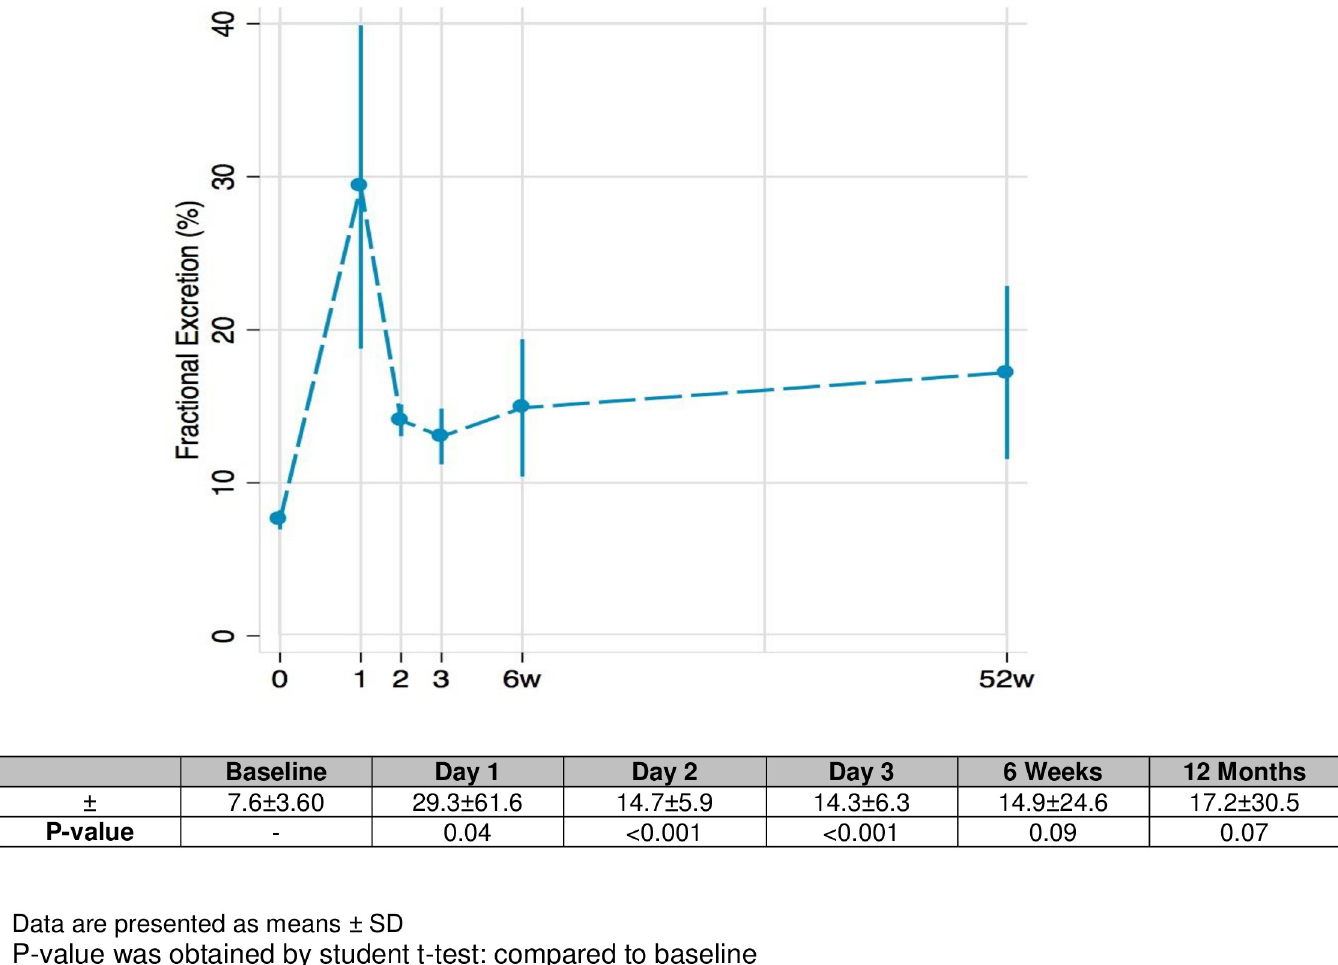
Fig 3. Fractional Excretion of Phosphate (FEP) in donors. Data are presented as means ± SD. P-value was obtained by student t-test: compared to baseline.